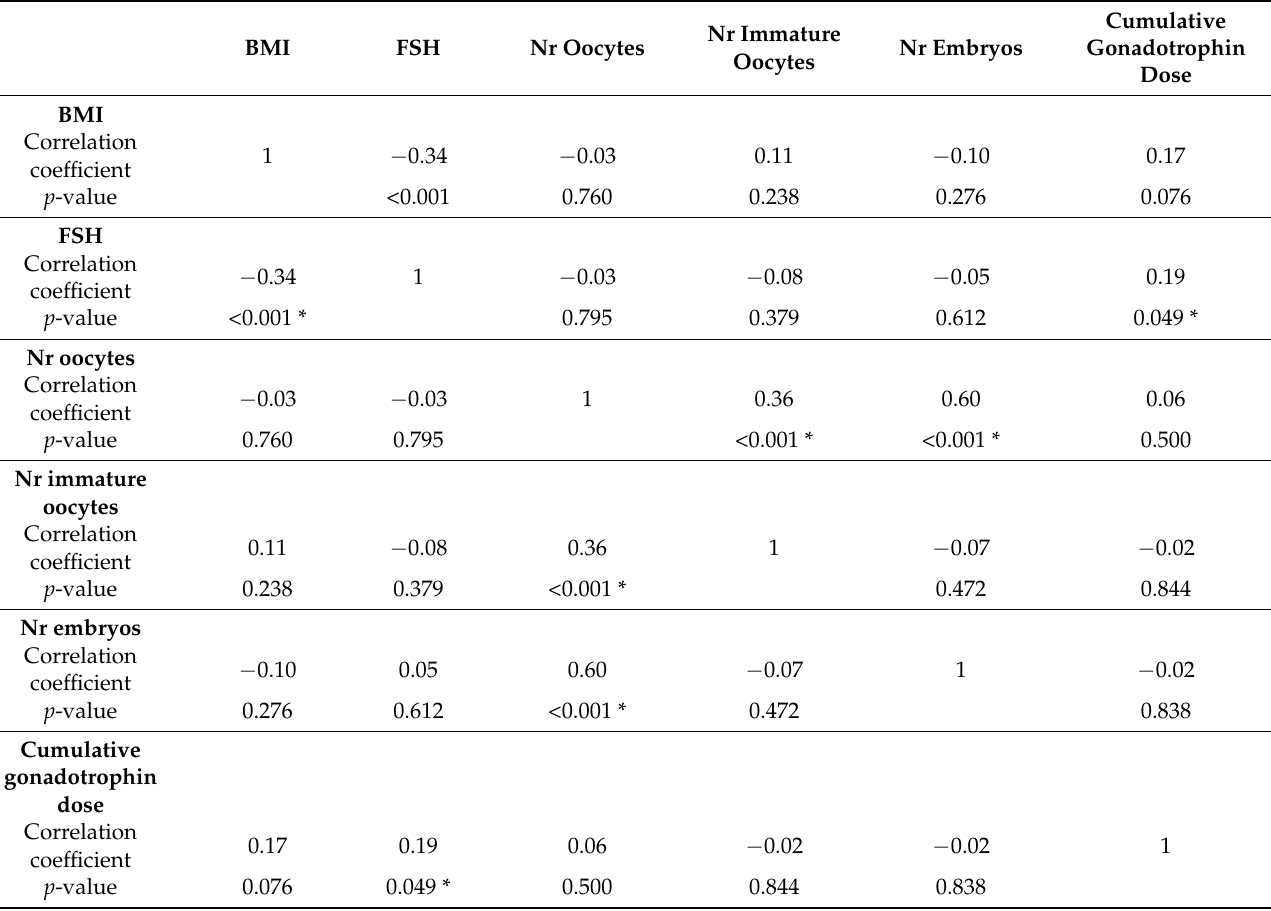
Table 4. Spearman’s correlation NOR patients. Statistically significant differences are marked with an asterisk ( p -value < 0.05).